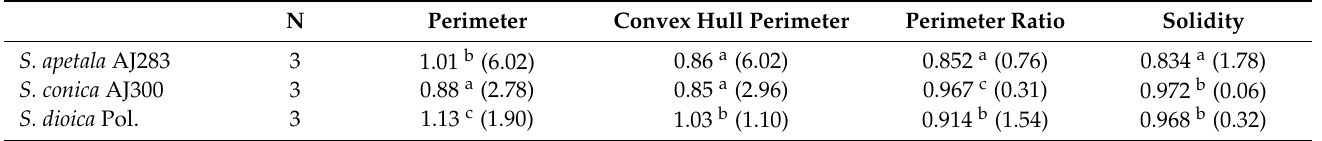
Figure 12. Average silhouettes for the dorsal views of 20 seeds of S. apetala AJ283, S. conica AJ300, and S. dioica Pol. with the corresponding convex hull superimposed. Table 1. Values of solidity and perimeter ratio (perimeter of the convex hull/ perimeter of the image) in three seeds for the dorsal views of the seed images of S. apetala AJ283, S. conica AJ300, and S. dioica Pol. Values marked with the same superscript letter in each column correspond to populations that do not differ significantly at p < 0.05 (Campbell and Skillings’s test). N indicates the number of seeds analyzed.